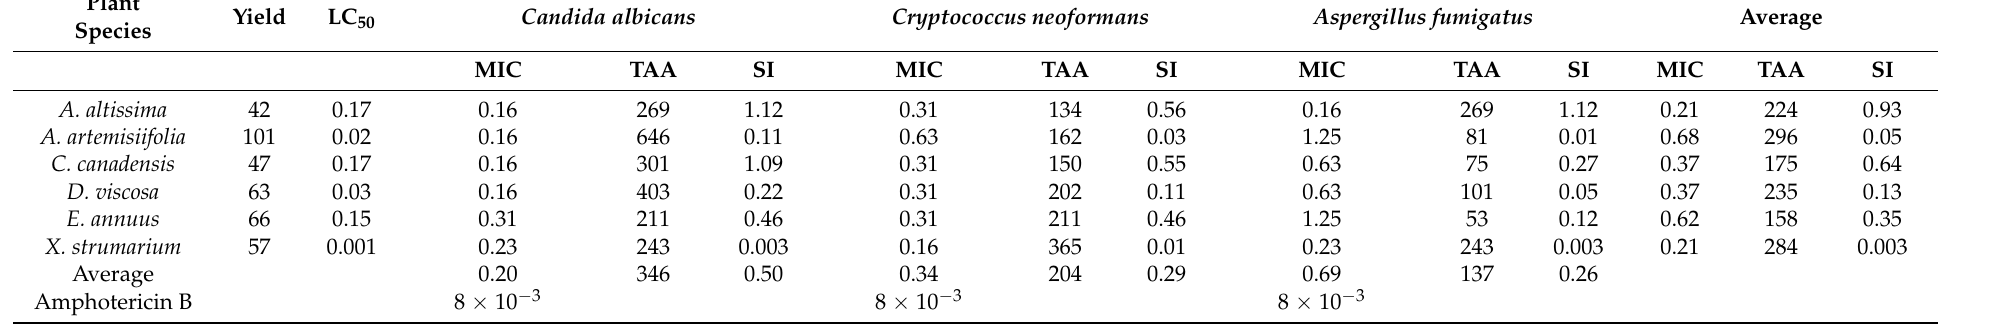
Table 3. Yield of extract (mg/g), cytotoxicity (LC 50 ) against Vero African green monkey kidney cells (mg/mL), minimum inhibitory concentration (MIC; mg/mL), total antifungal activity (TAA; yield/MIC) after 24 h incubation (ml/g), and selectivity indices (SI; LC 50 /MIC) of the acetone extracts of different plant species and amphotericin B (positive control) against test